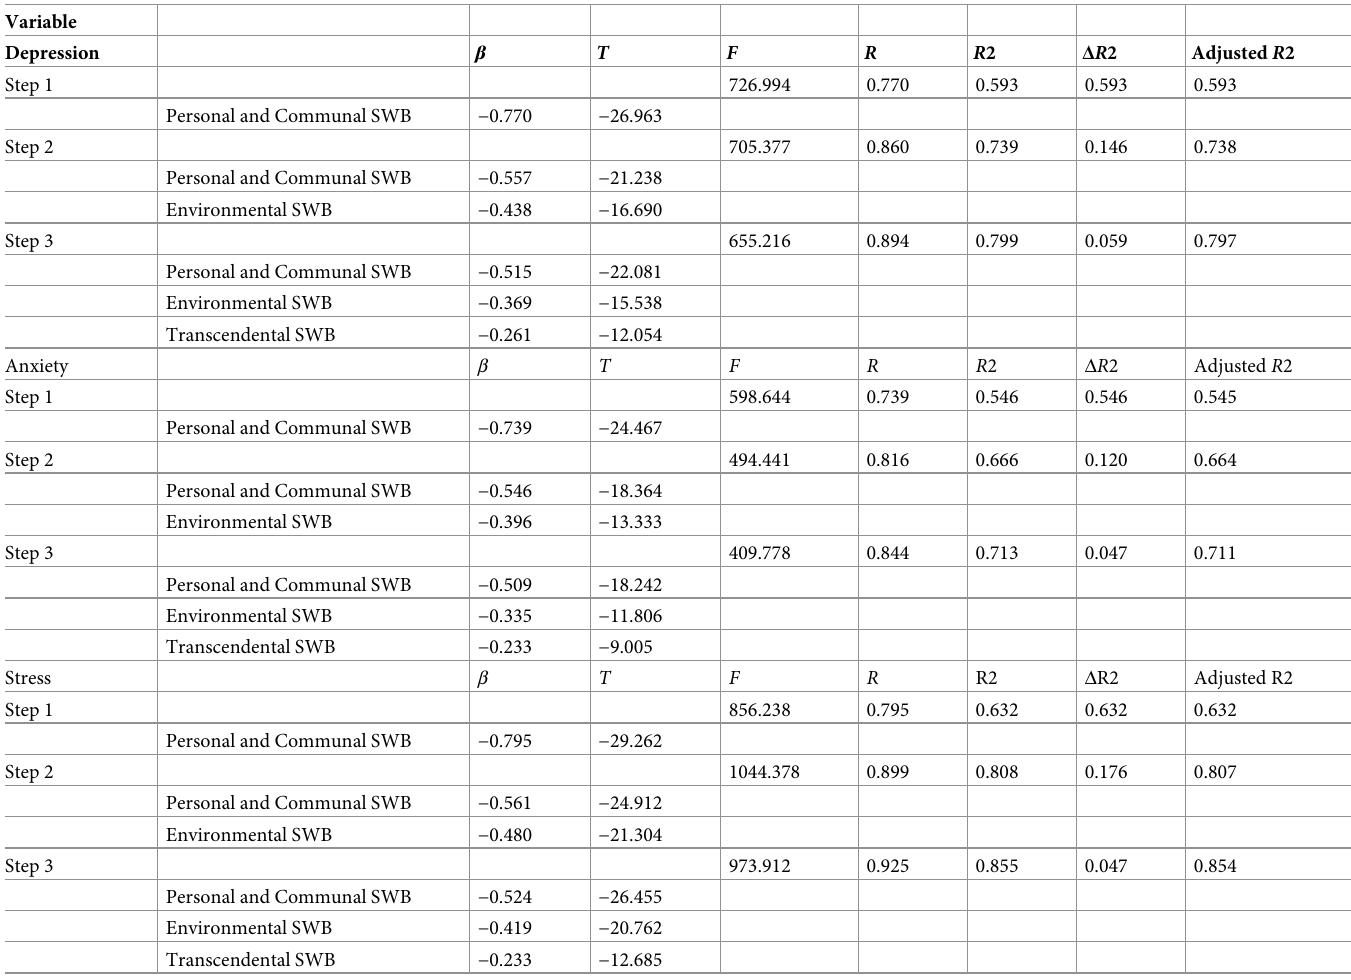
Table 5. Results of hierarchical regression analyses with spiritual wellbeing (SWB) in the personal and communal, environmental, and transcendental domains as predictors of participants’ depression, anxiety, and stress. Variable